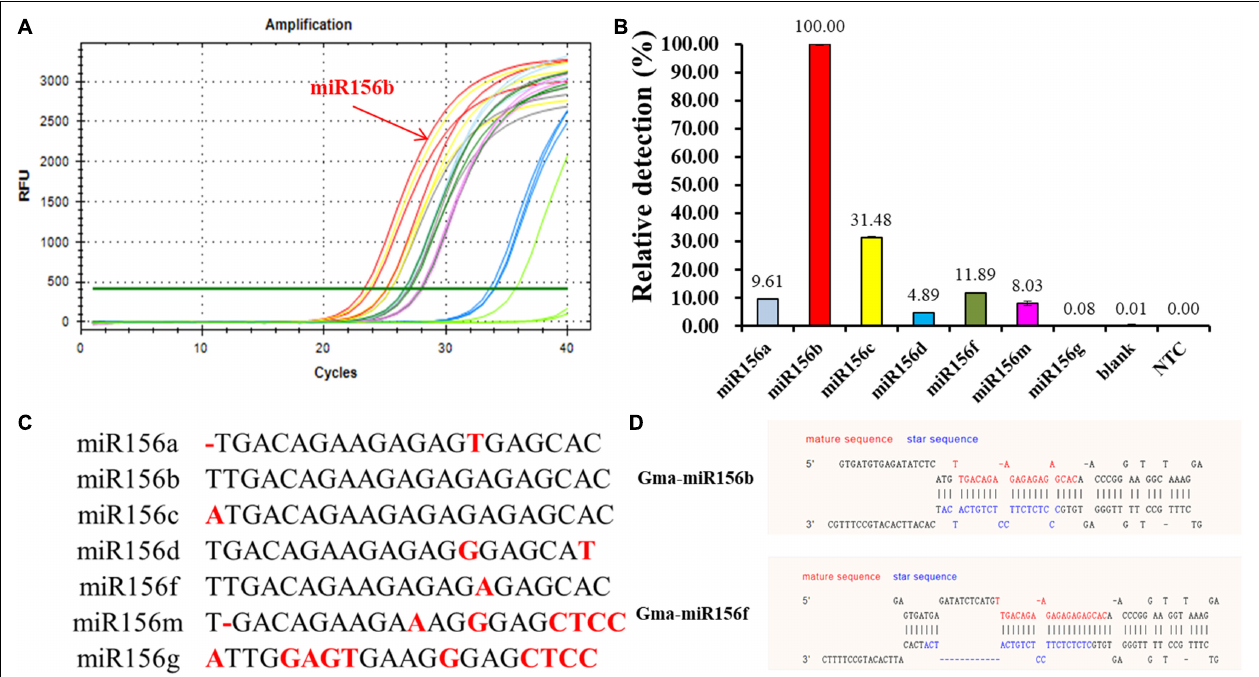
FIGURE 4 | Evaluation of specificity among miR156b family. (A) Amplification plot of synthetic miR156 family members; red line: miR156b; the other color lines: the highly homologous miR156 members. (B) Relative detection rate of miR156 family members. Blank was a negative control used miRNA-free ligation product as the amplification template; NTC was a quantitative reaction without any ligation product. (C) The alignment of all miR156 sequences. Nucleotides that differ from those in miR156b are highlighted. (D) The structural difference between GmmiR156b and